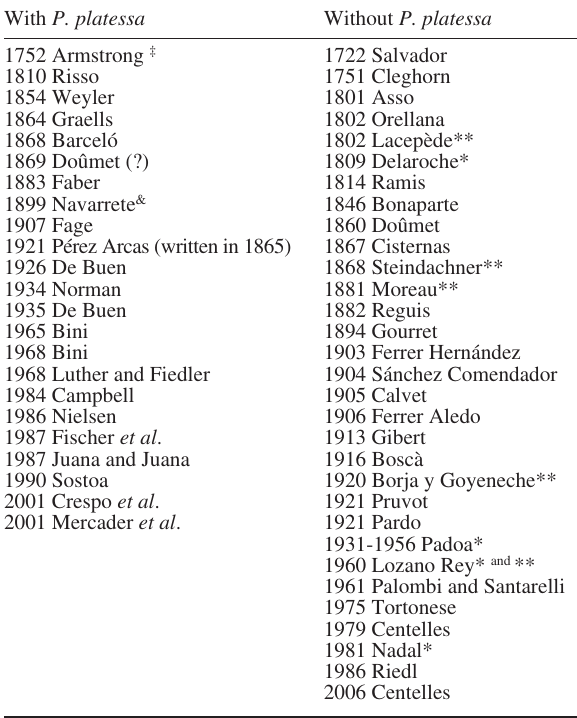
Table 1. – References of lists of Mediterranean fishes with and without Pleuronectes platessa, since the 18th century. With P. platessa